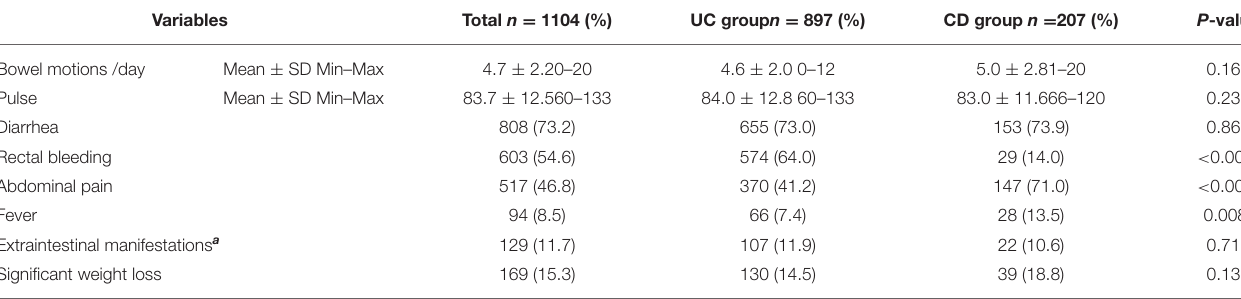
TABLE 2 | Clinical characteristics of patients with inflammatory bowel disease in Egypt (May 2018 to August 2021).